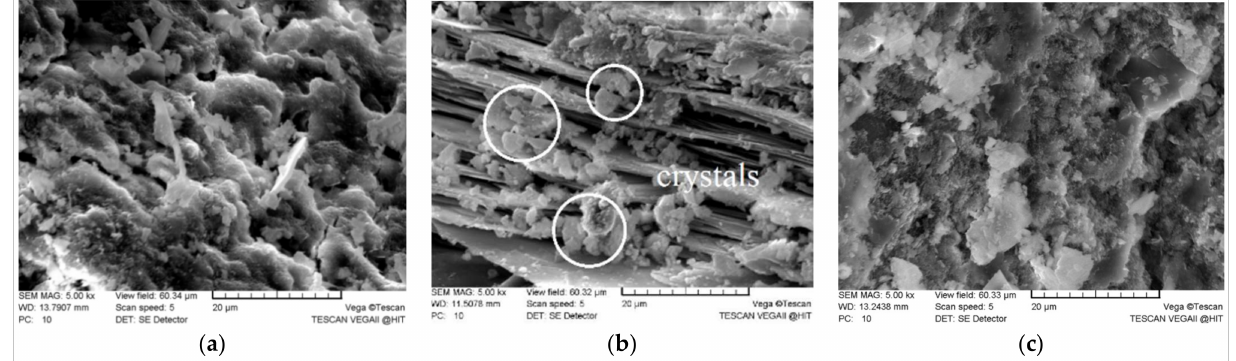
Figure 5. SEM images of plain concrete in different temperatures: ( a ) 29, ( b ) 37, and ( c ) 45 ◦ C.